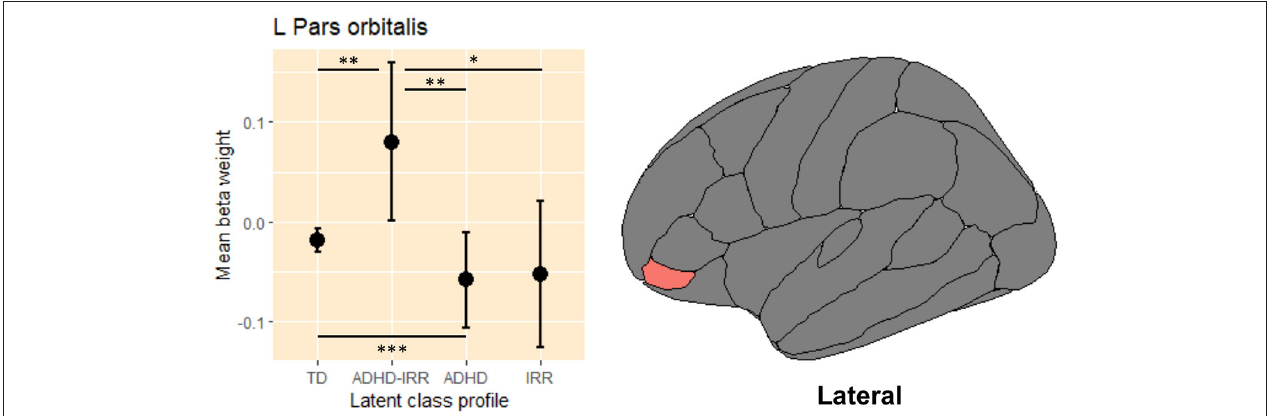
FIGURE 4 | Average beta weights of regional activation in the left pars orbitalis during error processing. L, left hemisphere; ADHD, attention-deficit/hyperactivity disorder; IRR, irritability; TD, typically developing. Raw average beta weights and standard errors of regional activation in the left pars orbitalis during error processing across the four latent classes of youths. * p ≤ 0.05, ** p ≤ 0.01, *** p < 0.001.